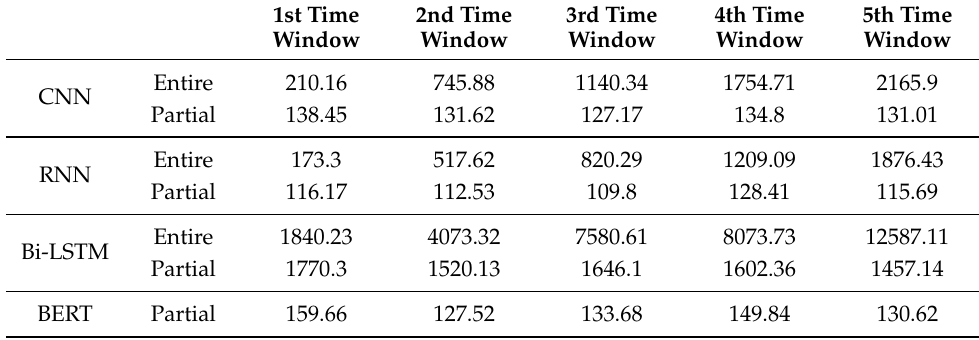
Table 5. The learning time of the proposed strategies on the disaster dataset (seconds).